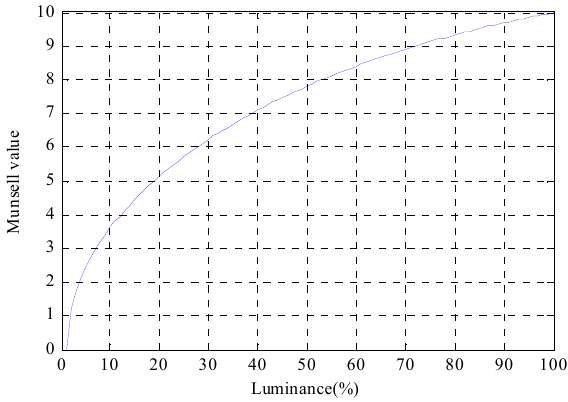
Figure 3. Munsell value vs. luminance.